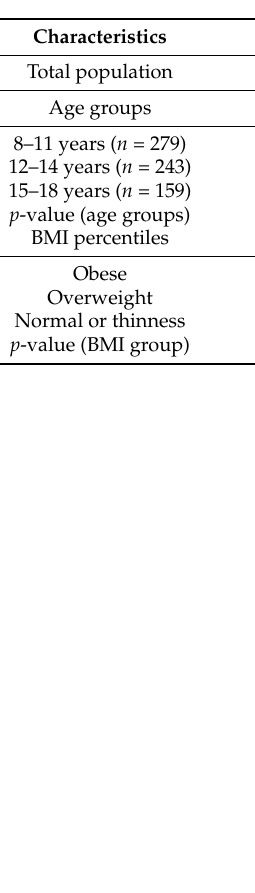
Figure 1. The distribution of serum proprotein-convertase-subtilisin/kexin type 9 (PCSK9) in the overall population. Table 2. The relationship between PCSK9 levels and age and Body Mass Index (BMI). The PCSK9 concentrations (ng/mL) are expressed as median with interquartile ranges (1st quartile–3rd quartile). The Mann–Whitney U test was used to calculate the p values of PCSK9 between boys and girls. The Kruskal–Wallis test yielded p values for age groups and BMI categories.